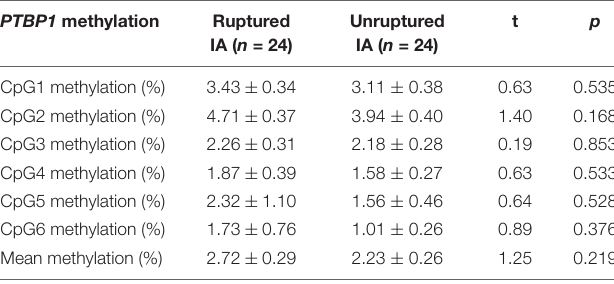
TABLE 4 | Characteristics of ruptured IA and unruptured IA.